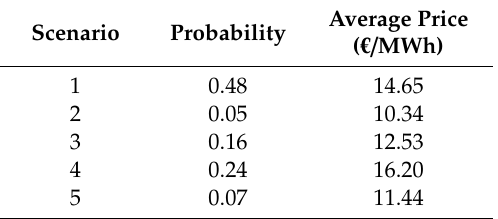
Figure 12. Expected spark price and expected prices of electricity and natural gas.